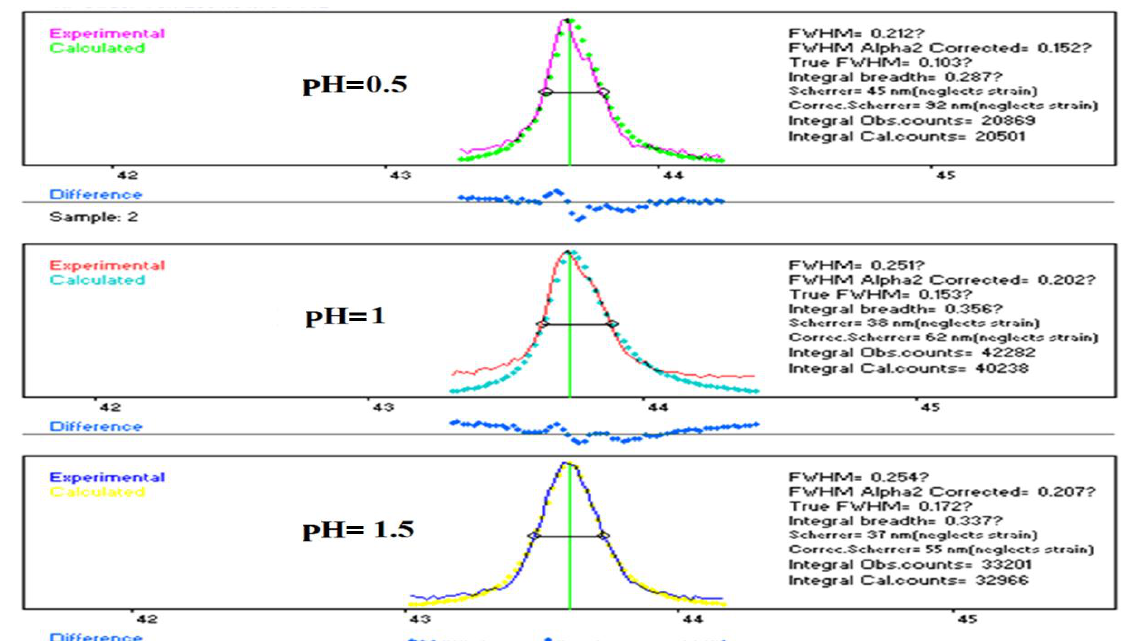
Fig. 3: XRD preferred peak profile for Cu along (111) direction at different pH (0.5, 1 and 1.5). Table 1: XRD data of CuNPs produced by electrochemical sonication of CuSO pH (0.5, 1 and 1.5), for 1min with sonication power of 400 W. FWHM pH 2θ (Deg.)